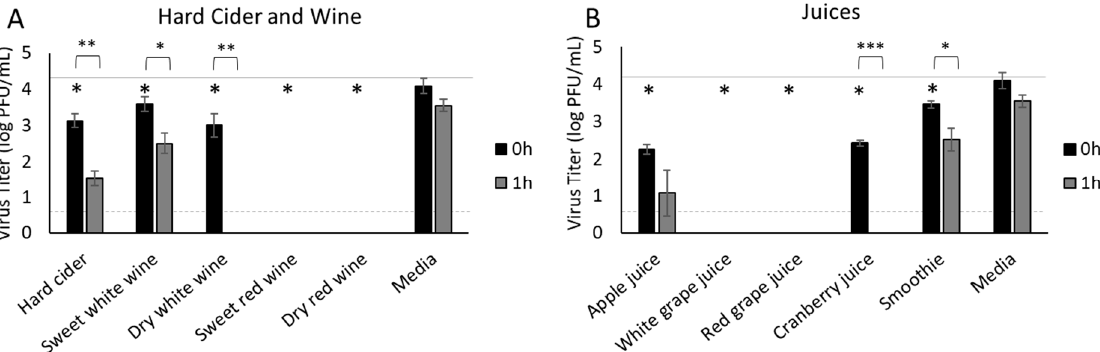
Figure 4. Survival of SARS-CoV-2 in hard cider, wine, and fruit juices. SARS-CoV-2 was recovered from hard cider and wine ( A ) and fruit juices ( B ) immediately after inoculation (0 h) and 1 h later. Infectious virus was quantified by plaque assay on Vero E6 cells and shown as log PFU/mL. All beverages significantly reduced infectious virus immediately after inoculation at 0 h compared to inoculum ( p < 0.0001). The inoculum is shown as a solid gray line (4.3 log PFU/mL) and the detection limit of the plaque assay is shown as a dashed line (0.7 log PFU/mL). Significant differences between 0 h and inoculum are shown with an asterisk. Significant differences between means at 0 h and 1 h are shown by brackets and asterisks (* <0.05; ** <0.01; *** <0.001). Error bars =